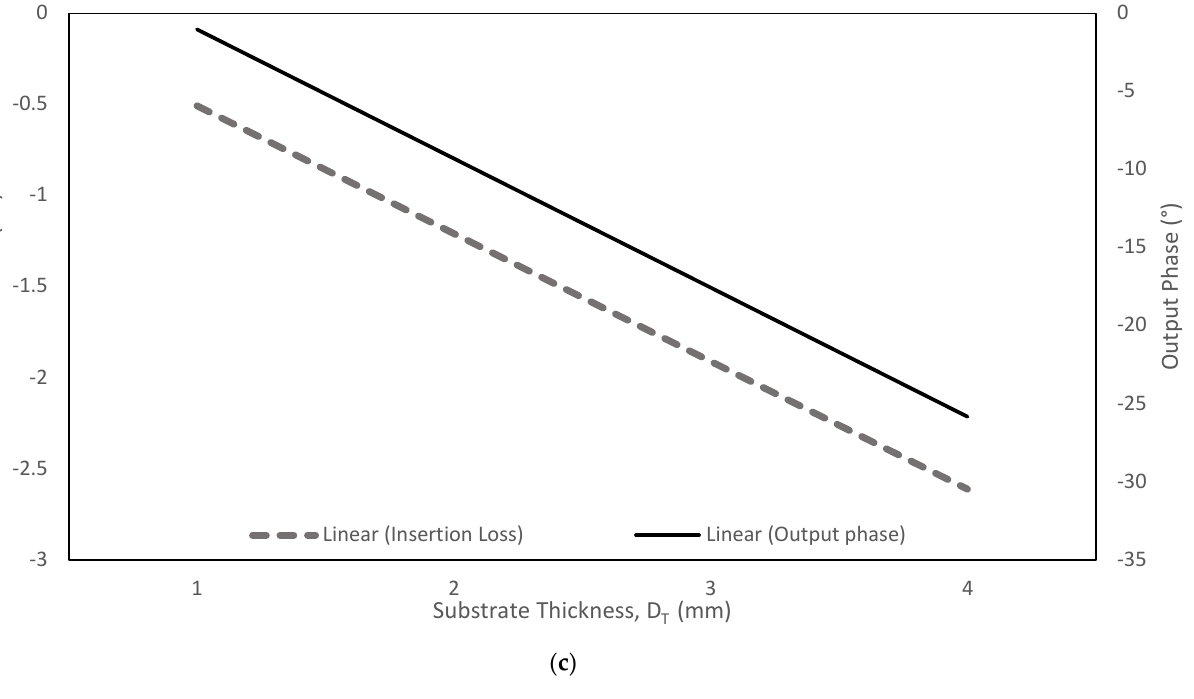
Figure 8. Parameter analysis towards the insertion loss: ( a ) circular slot diameter, Ds ; ( b ) via-hole pin diameter, D P ; and ( c ) substrate thickness, D T .